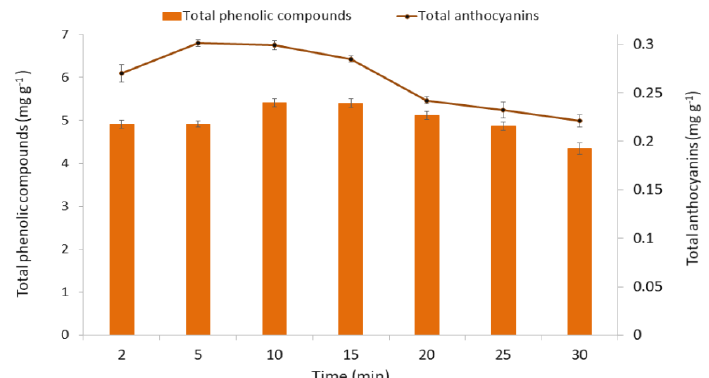
Figure 7. Optimal extraction time of anthocyanins and total phenolic compounds. Results are expressed as mg g − 1 of fresh weight (FW). All results are expressed as means ± standard deviation (SD) ( n =